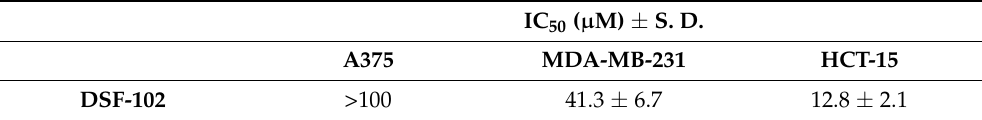
Figure 8. Confocal microscopy evaluation. Images show the localization of EGFR (green) and lysosomal marker LAMP1 (red) in A549 cells resting (time 0′) ( A ) or treated for 60 min with DSF-102 (50 μM) and/or EGF (100 ng/mL) ( B ). For each picture, a region of interest of was included at higher magnification. Nuclei were counterstained with DAPI (blue). Scale bar: 10 μm. Table 1. Cytotoxicity data for DSF-102 against different cell lines. Cells (5–8 × 10 3 mL − 1 ) were treated for 24 h with increasing concentrations of the tested compound. The cytotoxicity was assessed by the MTT test. IC 50 values were calculated by a four-parameter logistic model ( p < 0.05). S. D. = standard